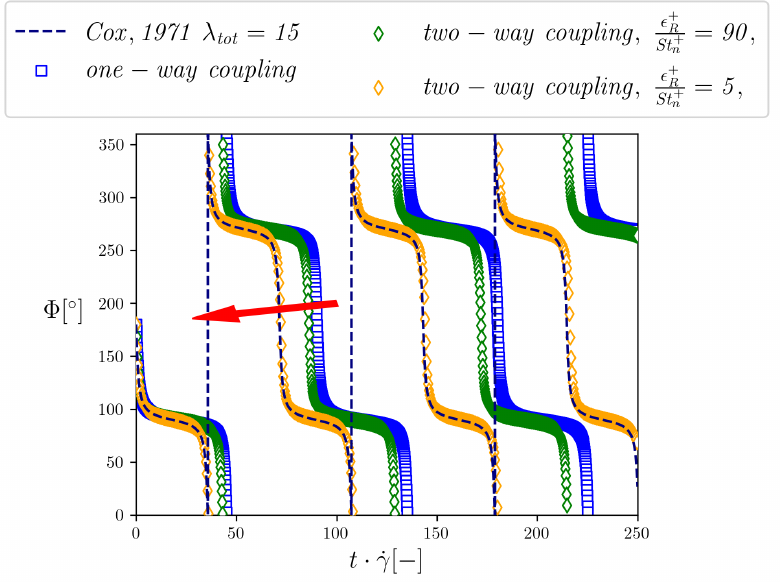
Figure 7. Time evolution of the angle Φ , defined as the angle between the gradient direction of a viscous shear flow and the particle orientation vector. Here, the fiber is assembled as a chain of five rods of aspect ratio λ r = 3 so that the total aspect ratio is λ tot = 15; bending is avoided by imposing a large-enough value of the Young modulus. The dotted curves represent the Jeffery orbits, obtained from calculations over progressively refined grids, while the dashed line is the analytical solution, obtained from Jeffery theory [34] through the equivalence of shape of Cox [35]. The red arrow indicates the progressive refinements of the Eulerian grid: A grid refinement of 2 × 2 × 2 on the number of grid points is introduced between each